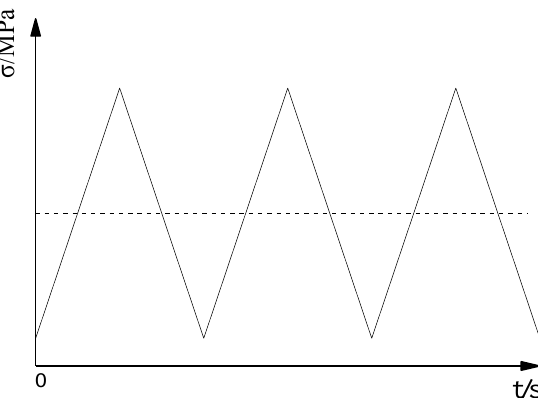
Figure 8. Schematic of loaded cyclic stress on the joint.